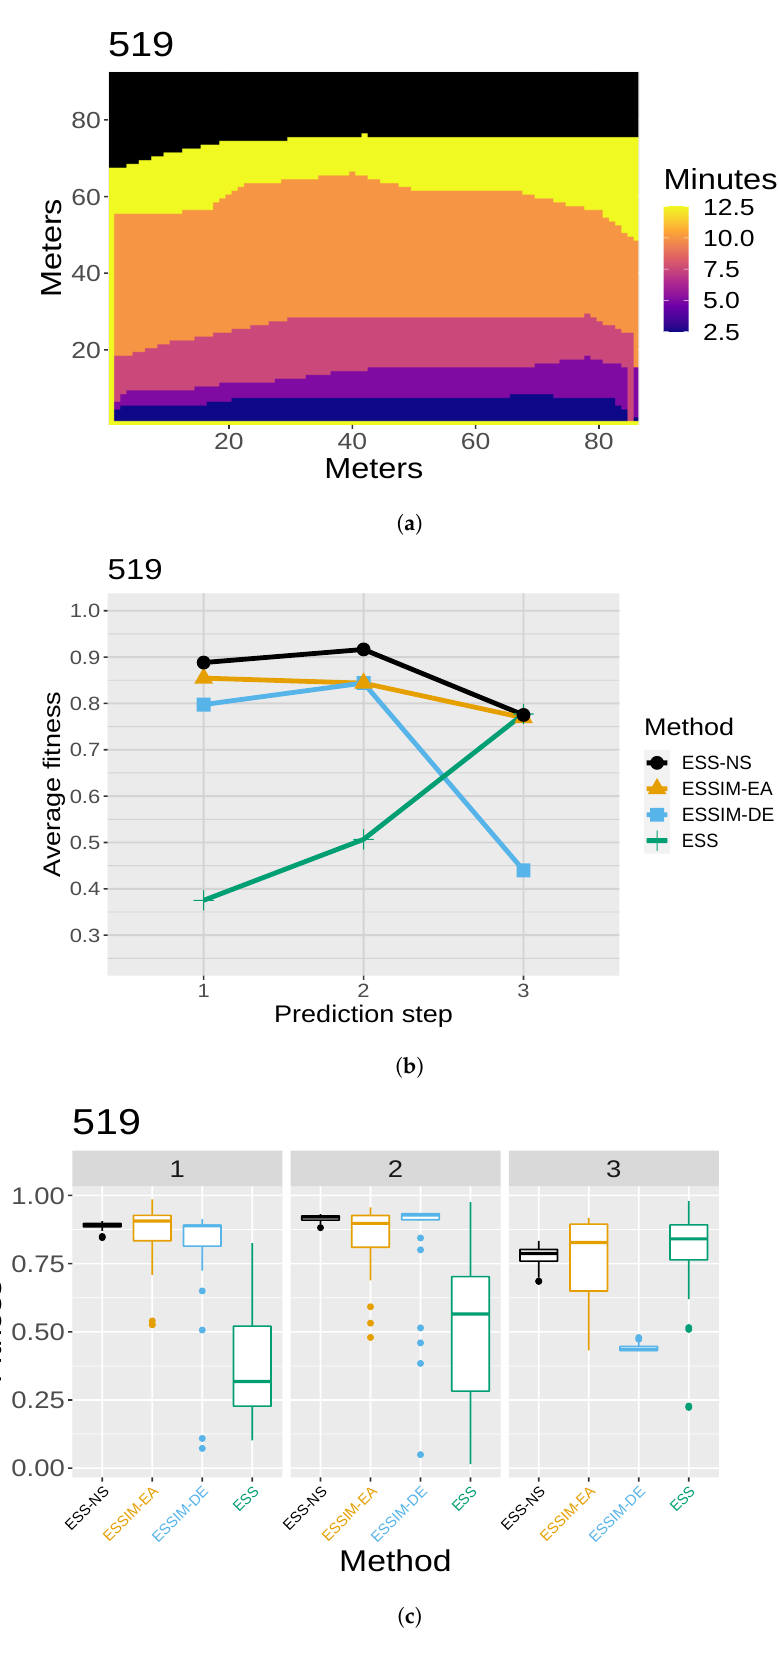
Figure 10. Case 519: ( a ) map of the real fire spread; ( b ) fitness averages; and ( c ) fitness